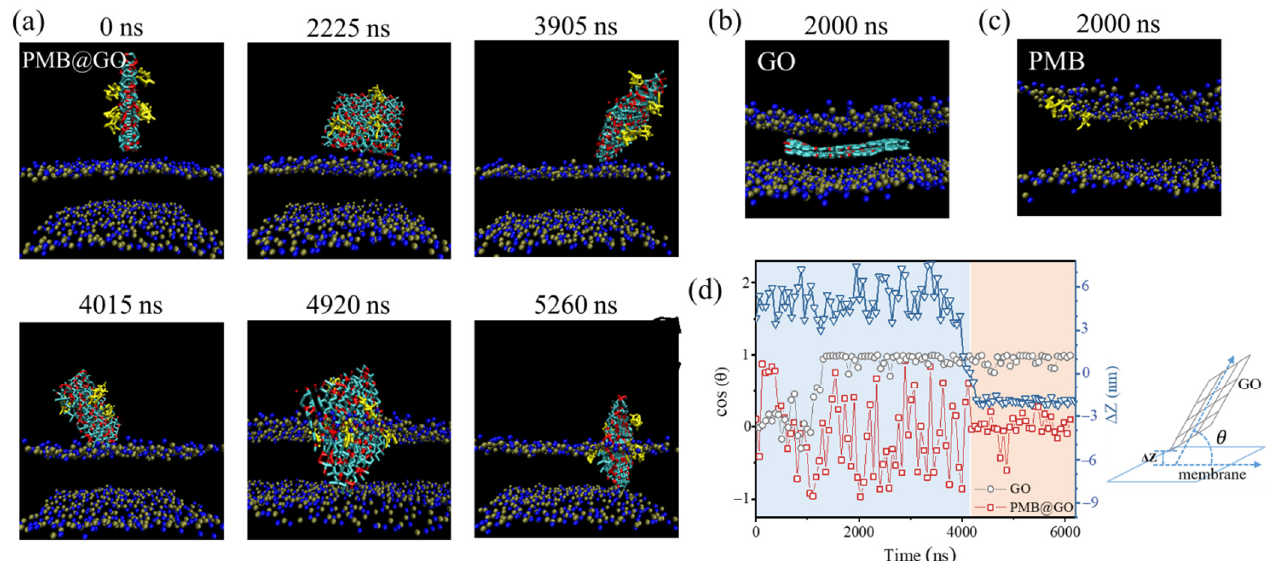
Figure 5. MD simulations of the membrane interaction with PMB@GO, free GO, or PMB. ( a ) Snap- shots showing the insertion dynamics of PMB@GO into a membrane. ( b , c ) Snapshots showing the membrane interaction state of GO or PMB at the end of simulations (2000 ns). ( d ) Corresponding time evolution of ∆ Z and cos ( θ ) of the PMB@GO and free GO during the membrane actions. Definition of ∆ Z and θ is shown on the right. Blue and grey beads in snapshots: phospholipid headgroups; yellow rod: PMB; light blue sheet with red beads: GO with hydrophilic groups. A membrane consisting of 512 lipids is performed and lipid tails are not shown for clarity. The GO sheet in ( a ) has a size of 7.2 × 6.3 nm and is decorated with 3 PMBs. The GO in ( b ) has a similar size as that in ( a ). In ( c ), three PMBs are added.